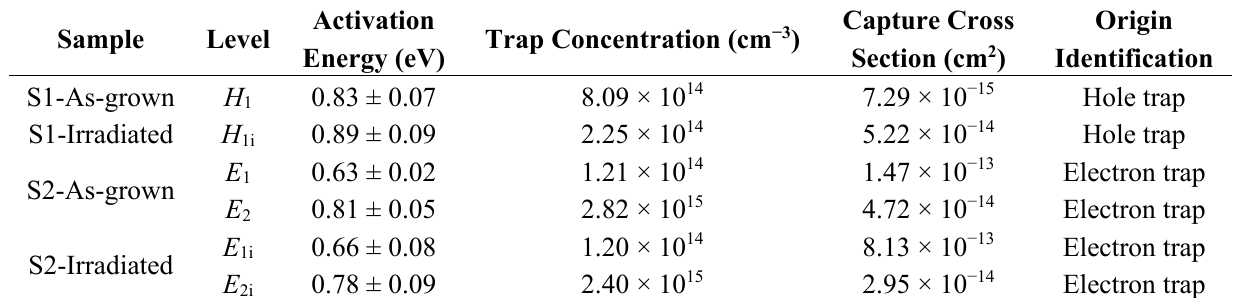
Figure 4. A typical capacitance deep-level transient spectroscopy (DLTS) spectrum recorded for both as grown and irradiated S2 samples with the following parameters: V R = − 0.5 V, V P = 0 V and the duration of the filling pulse was t p = 1 ms at rate window 500 s − 1 . Table 1. Apparent activation energy, capture cross section, and trap concentration of the defects observed on the sample S1 and S2 as-grown and irradiated. Recording condition: V R = − 0.5V, V P = 0V and the duration of the filling pulse was t z = 1